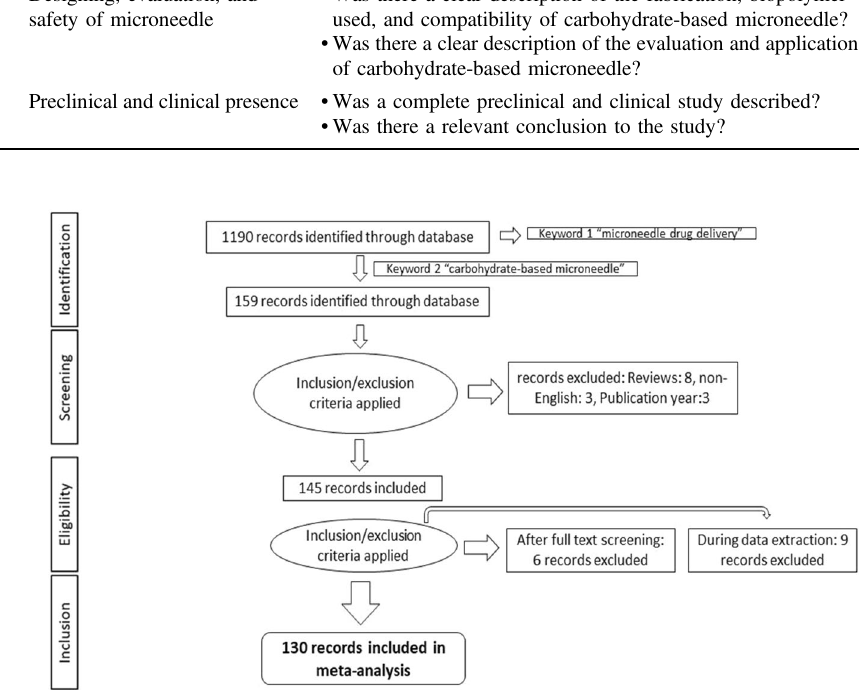
Table 1 Description of criteria listed for the selection of records for review